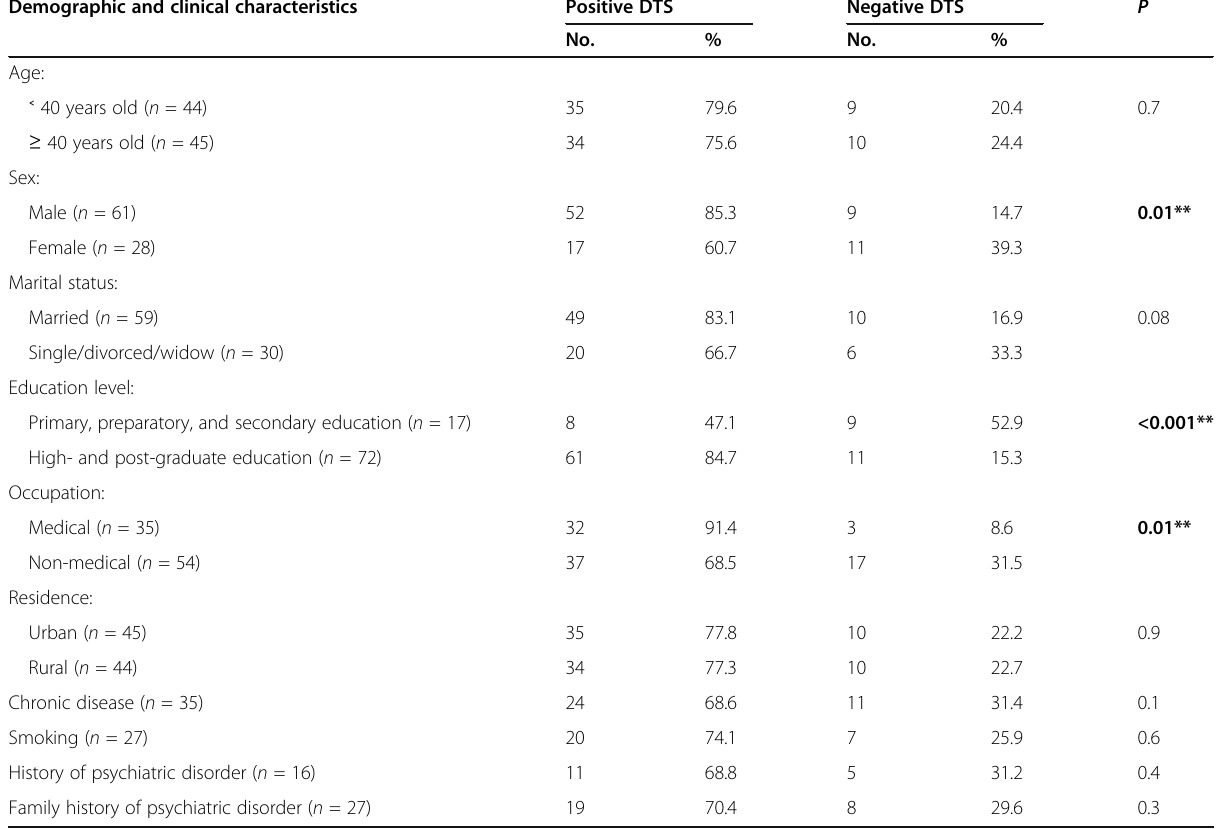
Table 5 Association between the Davidson Trauma Scale and demographic and clinical characteristics of the studied patients Demographic and clinical characteristics